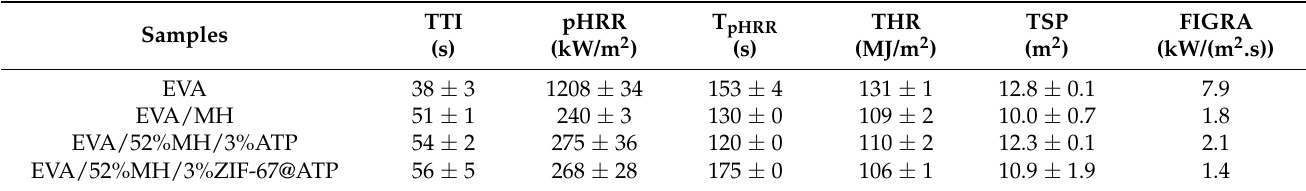
Table 3. CCT data of EVA and EVA composites.